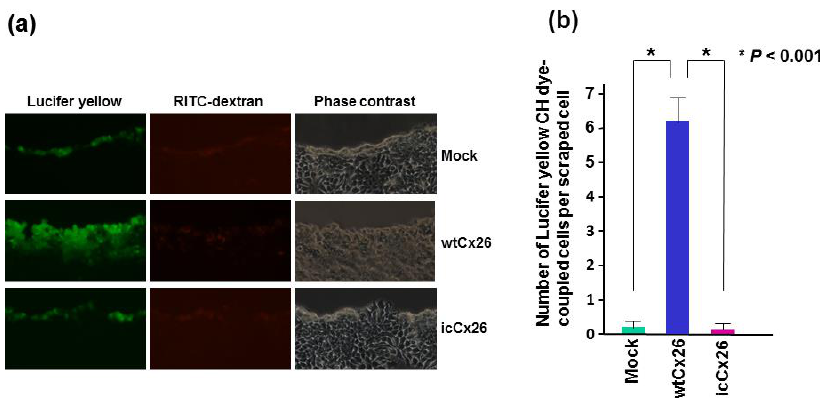
Figure 2. Scrape-loading dye-transfer assay to measure GJIC ability. The wtCx26, icCx26, and mock clones were soaked in a cocktail of Lucifer yellow CH and RITC-dextran, scraped by a micropipette tip, and observed under a fluorescence microscope after 5 min of incubation. ( a ) Representative micrographs of 3 different clones. The same fields of each clone were captured. Note that dye-coupled cells with Lucifer yellow CH were observed only in the wtCx26 clone. ( b ) Histogram showing the mean GJIC capacity of each clone. Error bars represent the SD ( n = 6).